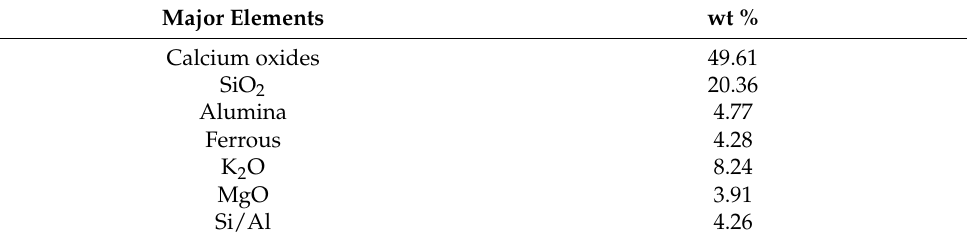
Table 1. Major elemental oxides of